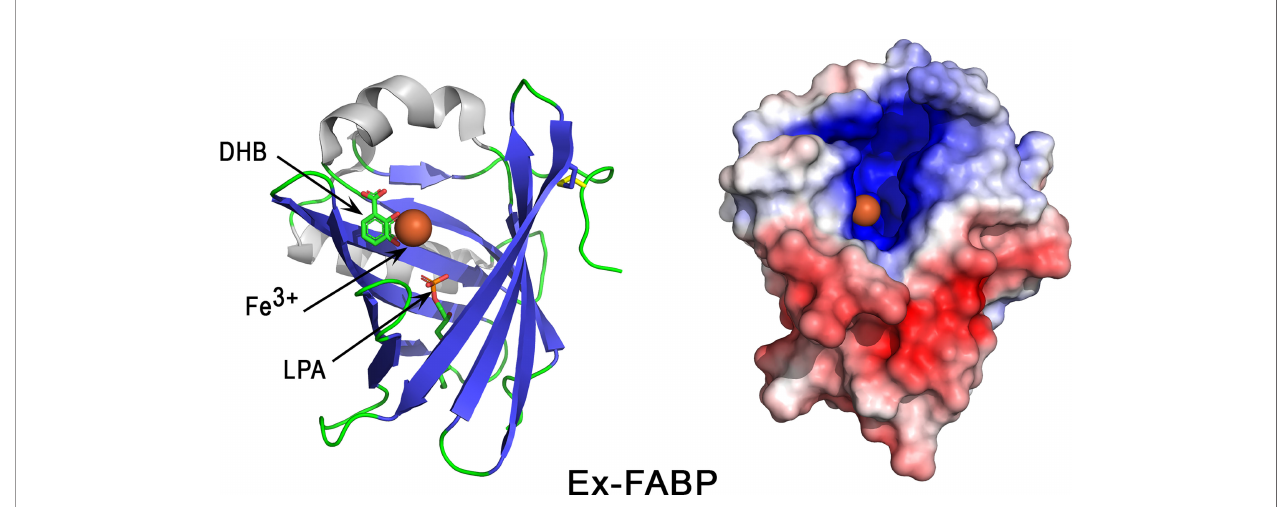
FIGURE 9 | 3D structure of the iron-chelator Ex-FABP. The left panel corresponds to the cartoon representation of 3D structure of chicken Ex-FABP while the right panel shows the color-coded electrostatic potential molecular surface. Color scheme ranges from red (negatively charged regions) to deep blue (positively charged regions). The fi gure shows an Fe 3+ ion (colored orange)-dihydoxybenzoate complex bound in one of the three subcavities of Ex-FABP calyx. Dihydroxybenzoate (DHB) and lysophosphatidic acid (LPA) are shown in stick representation. The fi gure was prepared using Pymol software (48) and APBS (Adaptive Poisson- Boltzmann Solver) plugin (49) for electrostatic calculations using 3SAO PDB fi le for chicken Ex-FABP